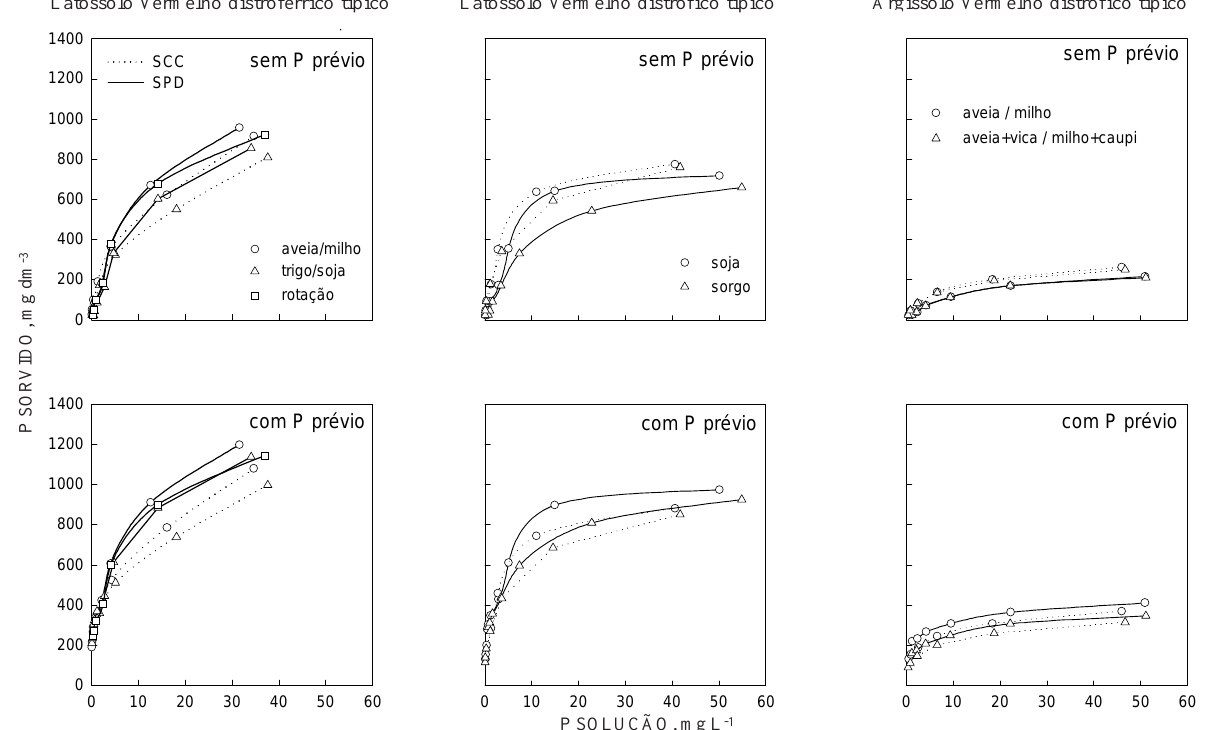
P SOLUÇÃO, mg L Figura 1. Relação entre o fósforo sorvido e o fósforo da solução da camada de 0-2,5 cm, sem e com a inclusão do fósforo previamente sorvido em diferentes solos, métodos de preparo e sucessões de culturas.